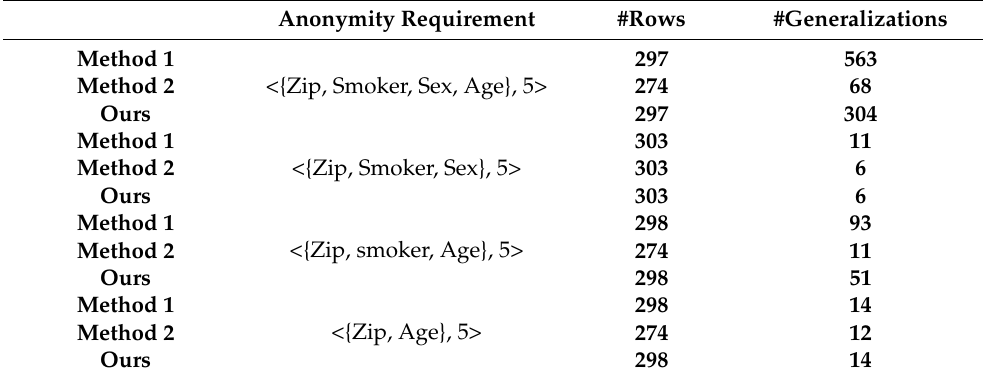
Table 7. Experiments with Different Anonymity